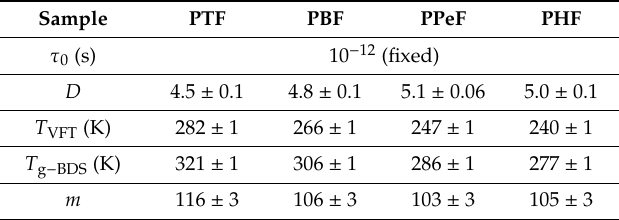
Figure 4. ( a ) Relaxation plot, ( b , c ) fitting parameters, and ( d ) FWHM, as a function of temperature for the segmental relaxations of FC poly(alkylene furanoate)s: ■ PTF, + PBF, ▲ PPeF, ● PHF. The low - temperature data for PBF (blue crosses) were adapted from Ref [28]. Table 3. VFT parameters obtained for the α -relaxation of poly(alkylene